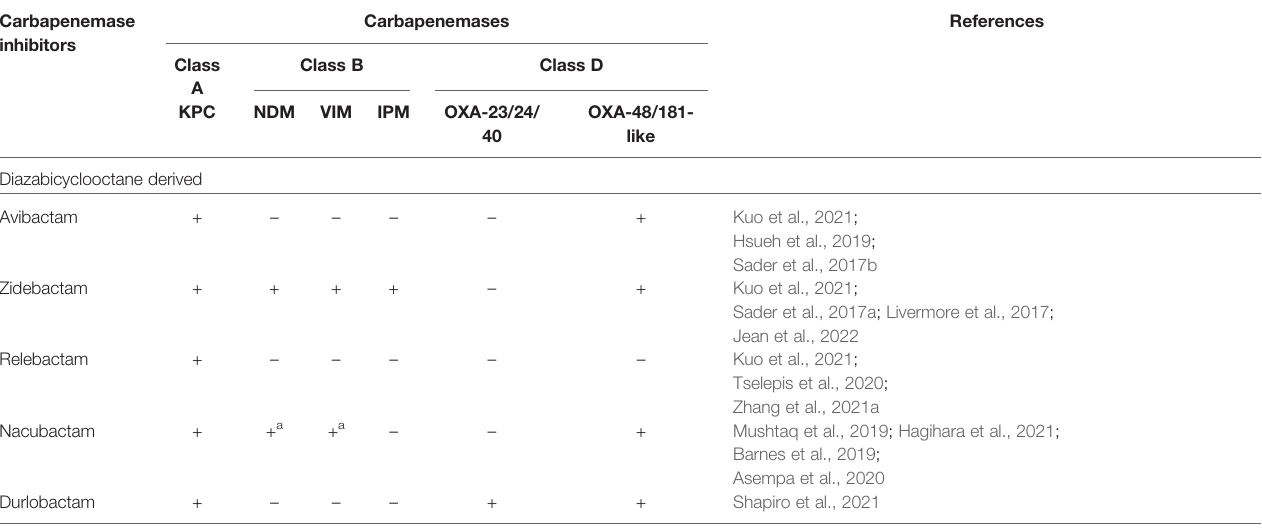
TABLE 5 | Spectra of important carbapenemase inhibitors against various carbapenemases on Gram-negative